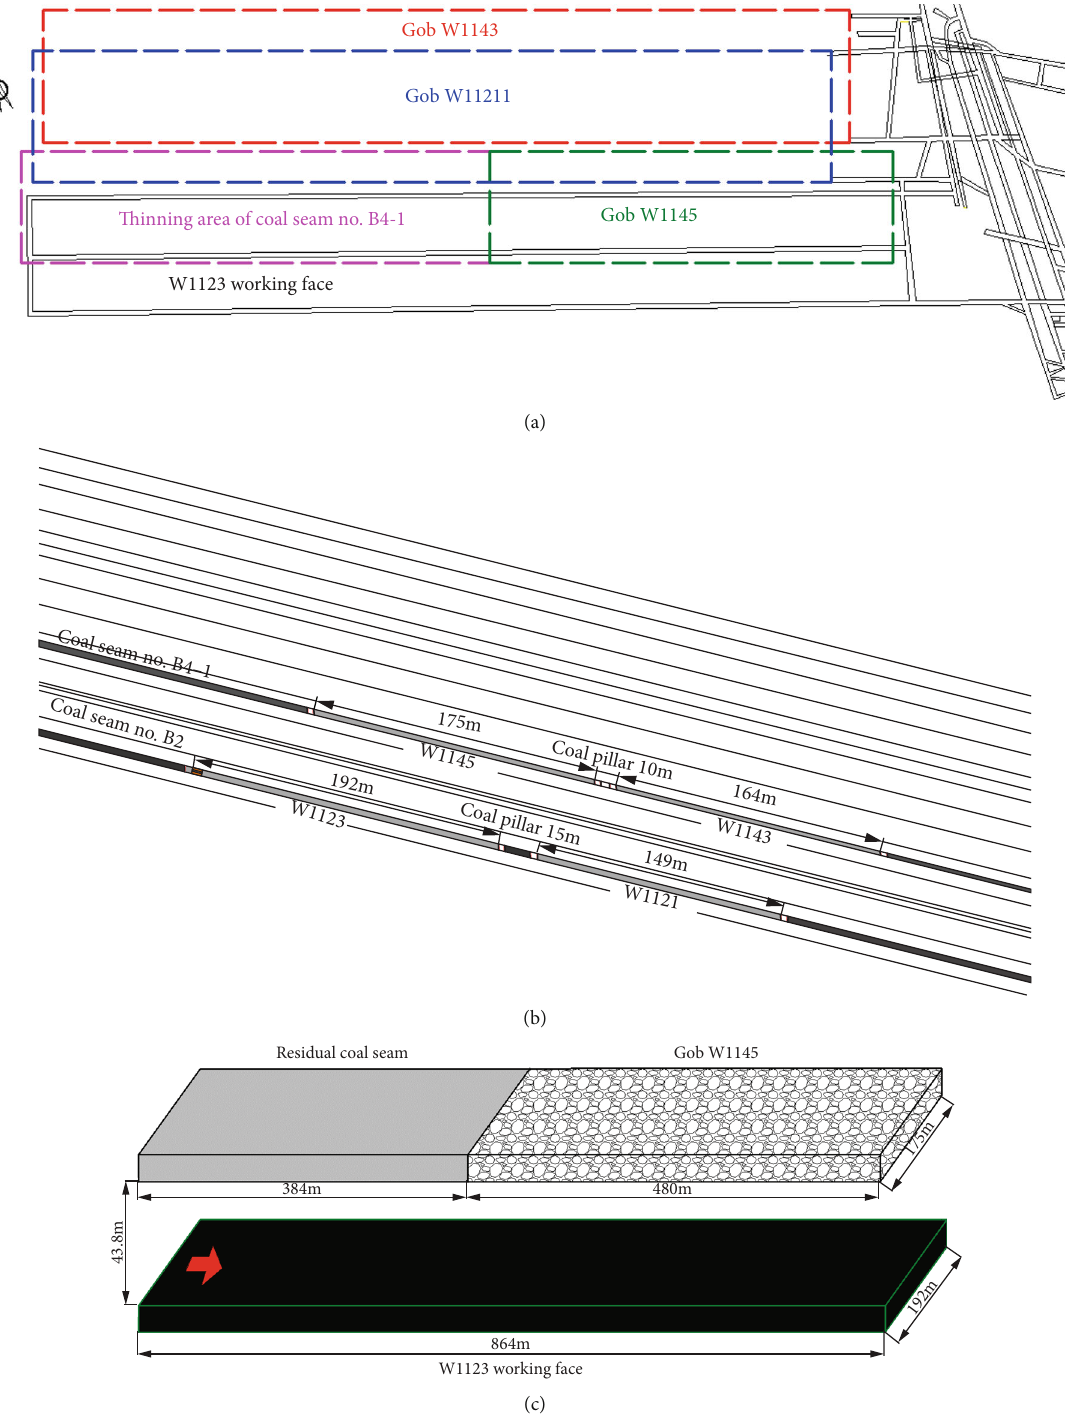
Figure 1: Structural diagram of the Kuangou Coal Mine. (a) Plane diagram of the mine. (b) Section diagram of the mine. (c) Schematic diagram of the close-range coal